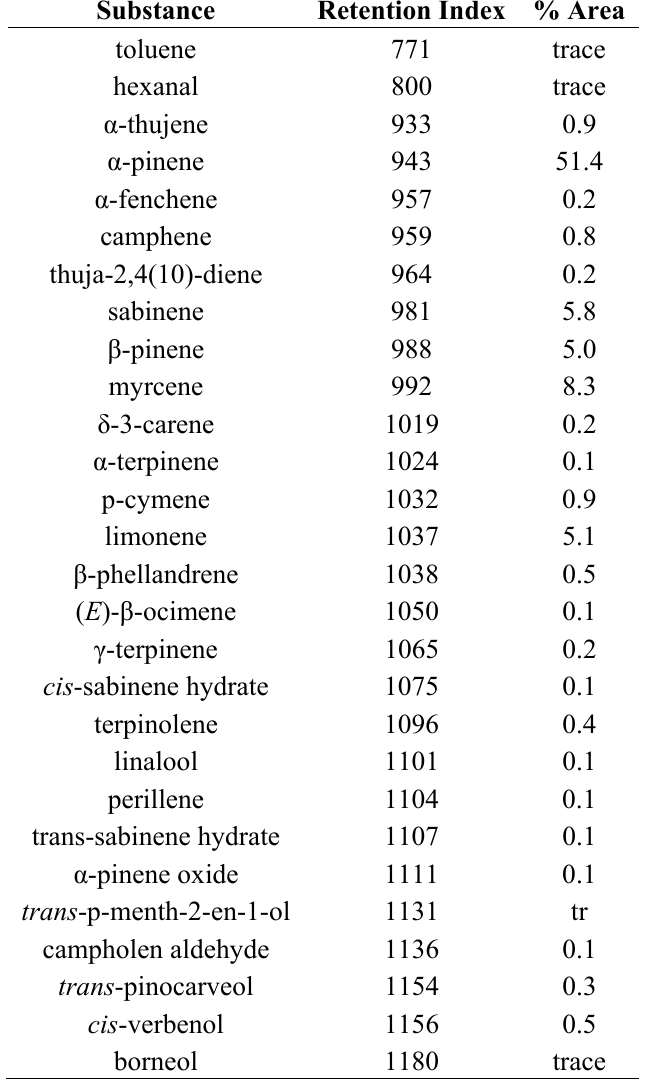
Table 1. Chemical composition of juniper berry